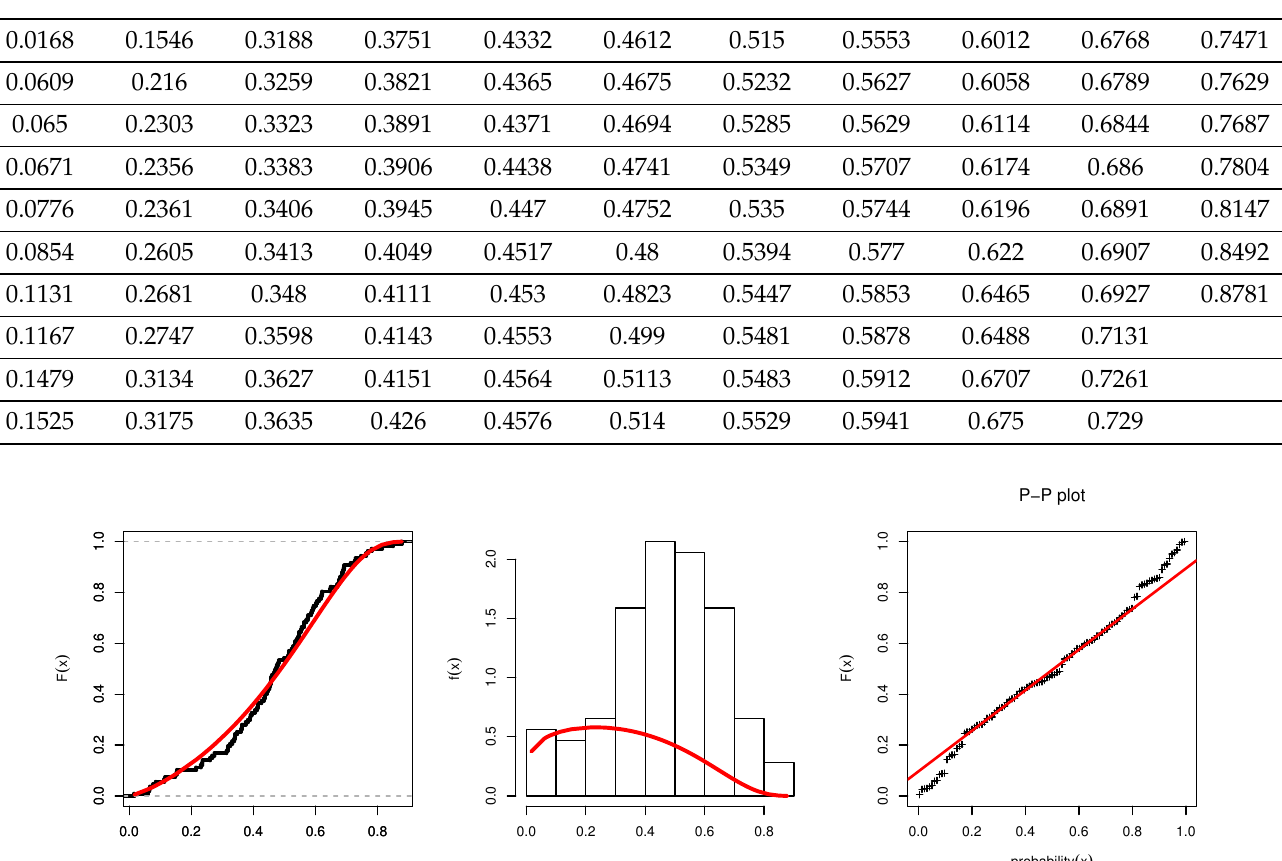
Table 7. Milk production data.